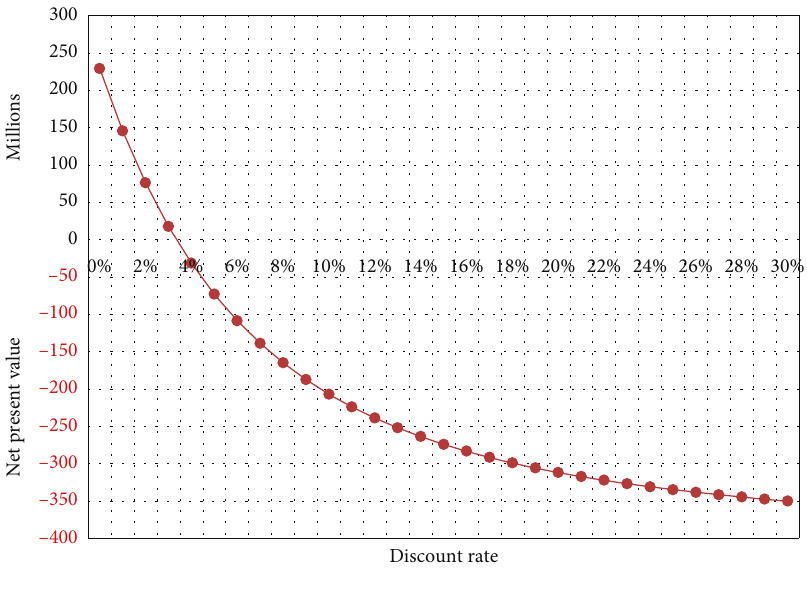
Figure 11: NPV for various discount rates with base case